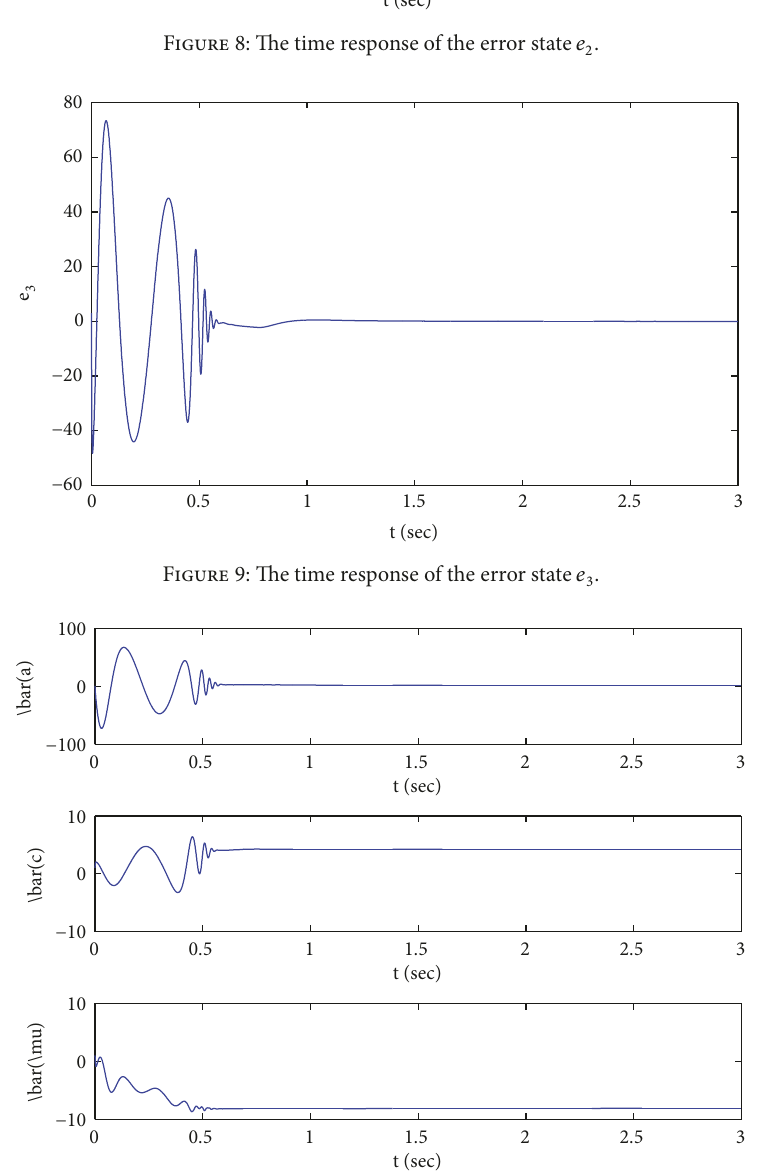
Figure 10: The time response of states 𝑎, 𝑐,𝜇